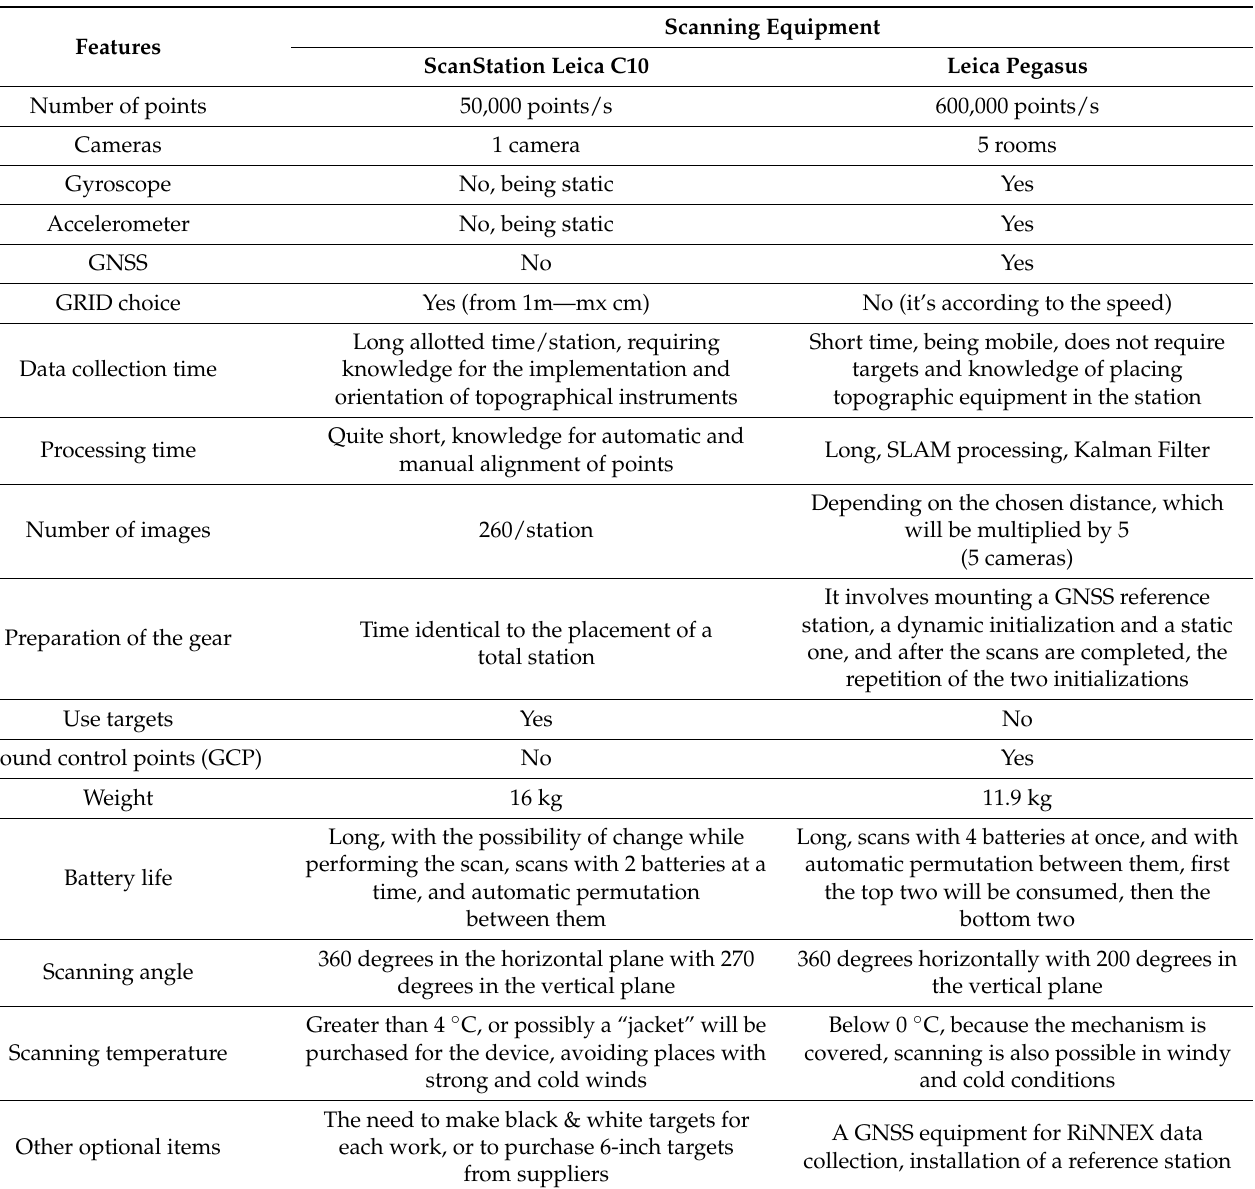
Table 17. Comparison of TLS—MMS scanning